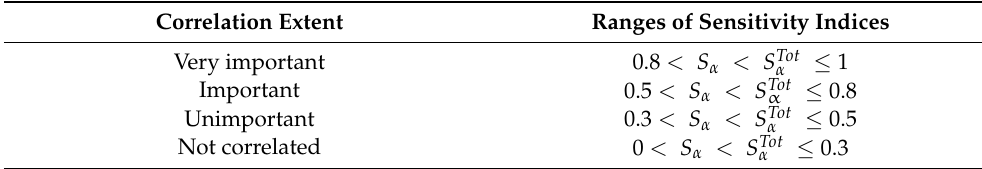
Table 6. Correlation extent for different ranges of sensitivity indices